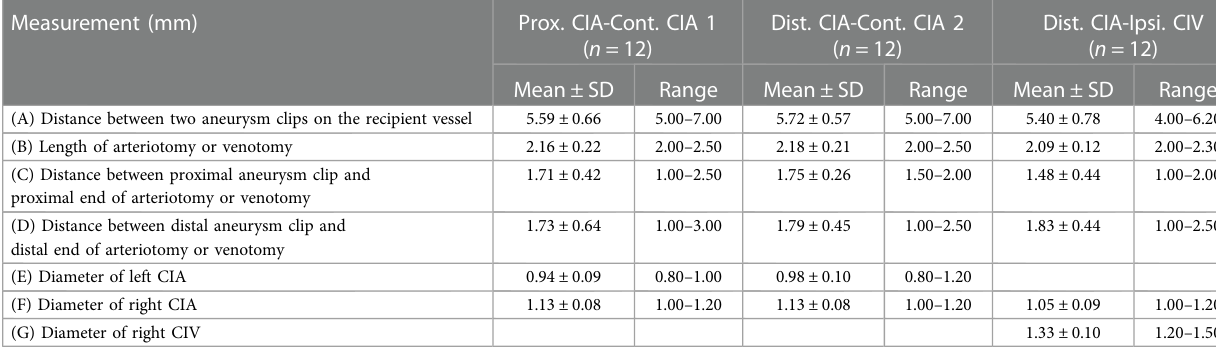
TABLE 1 Measurements in end-to-side microvascular anastomosis using rat CIA. Measurement